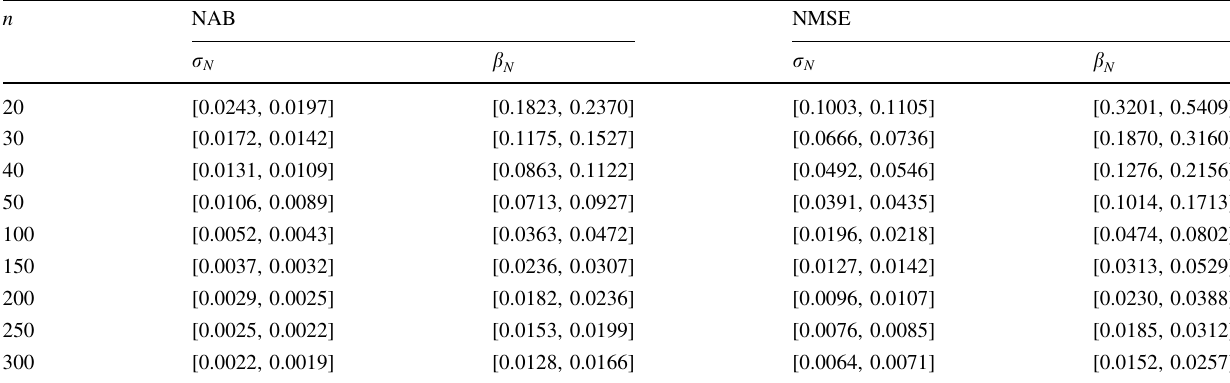
Table 4 Simulated average neutrosophic biases and MSEs of parameters when r N 2 2 : 0 ; 2 : 75 ½